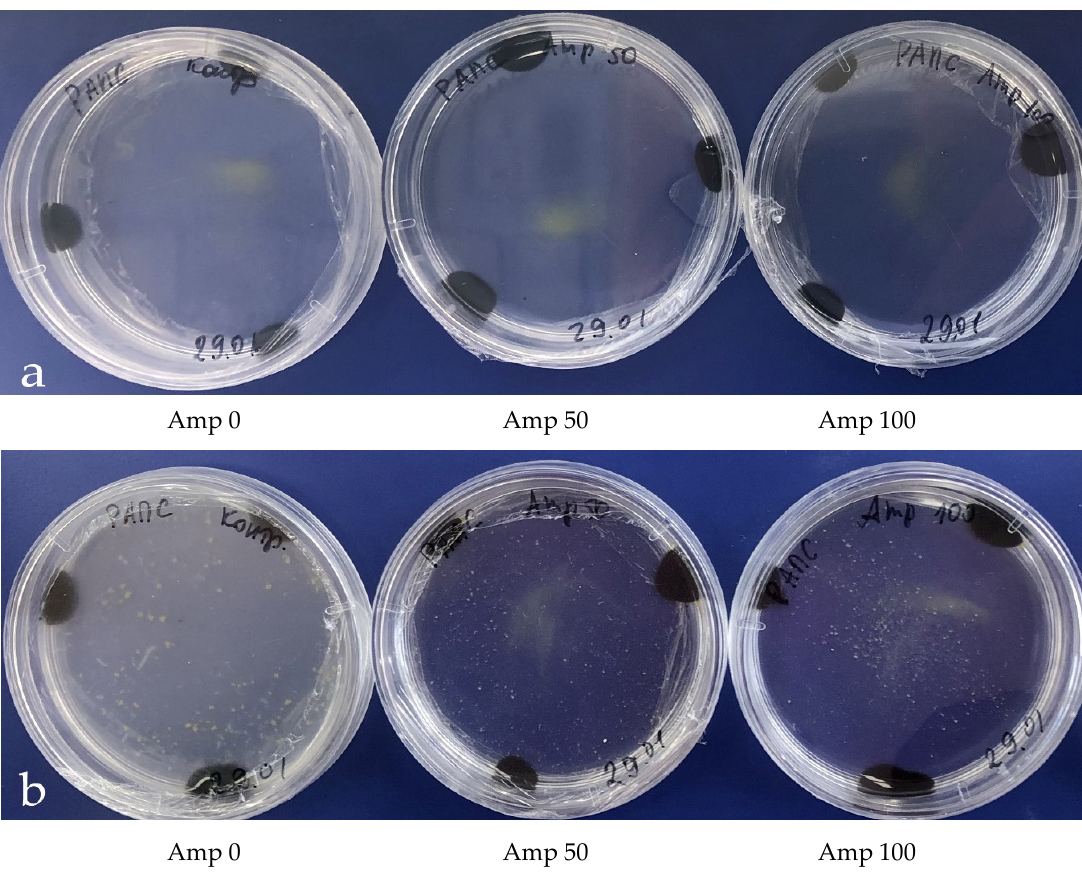
Figure 2. The development of embryos in in vitro microspore culture in B. napus : ( a ) first day of cultivation; ( b ) fifth day of cultivation (development of bacteria in media without antibiotics and absent any contamination in medium with ampicillin).